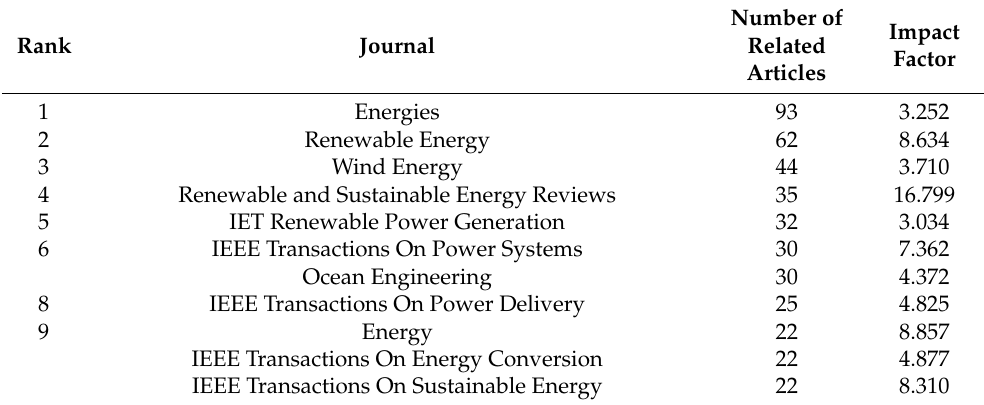
Table A1. The top 10 journals with the highest numbers of related research articles in 2005–2021.